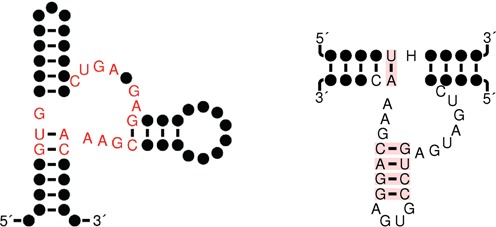
(Left) Target structure S used in computational experiment with RNAiFold, which determined that no sequence exists, having guanine at the cleavage site 8 along with those 15 nucleotides of Peach Latent Mosaic Viroid (PLMVd) AJ005312.1/282-335 having sequence conservation exceeding 96%, and which the Rfam consensus structure of PLMVd (i.e. whose RNAfold 1.8.5 MFE structure is the consensus secondary structure of of PLMVd). (Right) Hammerhead ribozyme (lower molecule) hybridized with trans-cleavage target RNA (upper molecule). Cleavage site NUH occurs at position 4–6 of the upper molecule, where ‘H’ denotes ‘not G’. RNAiFold shows that no two sequences s1, s2 exist, where s1 contains ‘GUG’ at positions 4-6, both s1, s2 contain the other indicated nucleotides, for which the indicated structure is the MFE hybridization of s1, s2. The nonexistence, as determined by RNAiFold, of any sequence folding into target structure S, which has GUG at the cleavage site and satisfies certain additional minimal constraints, strongly suggests that GUG is not a hammerhead cleavage site is due to the inability of the molecule to fold into a structure necessary for nucleophilic attack. Image of right panel adapted from figure 3A from (72), and both images produced by R2R (75).